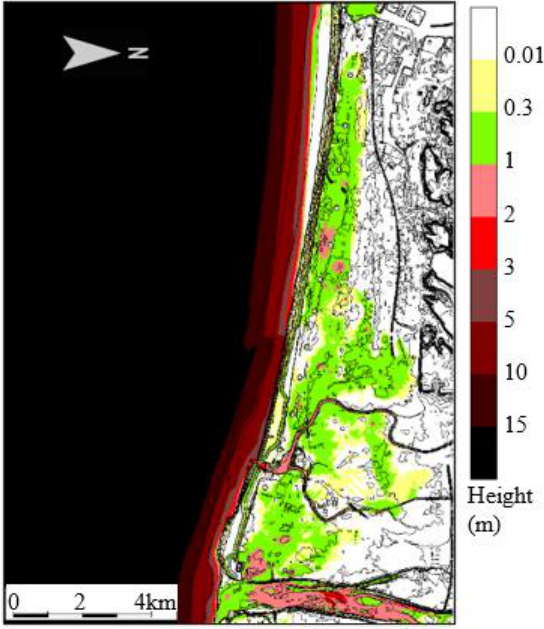
Figure 16. Inundation depths 33 min after the start of calculation (i.e., after structure developments).